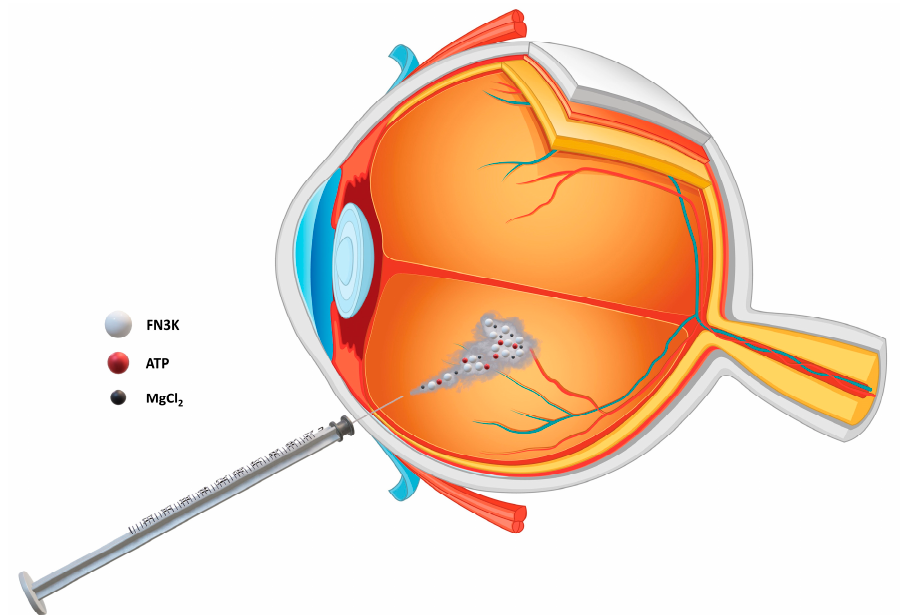
Figure 1. Intravitreal eye injection of a solution containing fructosamine-3-kinase (FN3K) and its cofactors adenosine triphosphate (ATP) and magnesiumdichloride (MgCl 2 ).